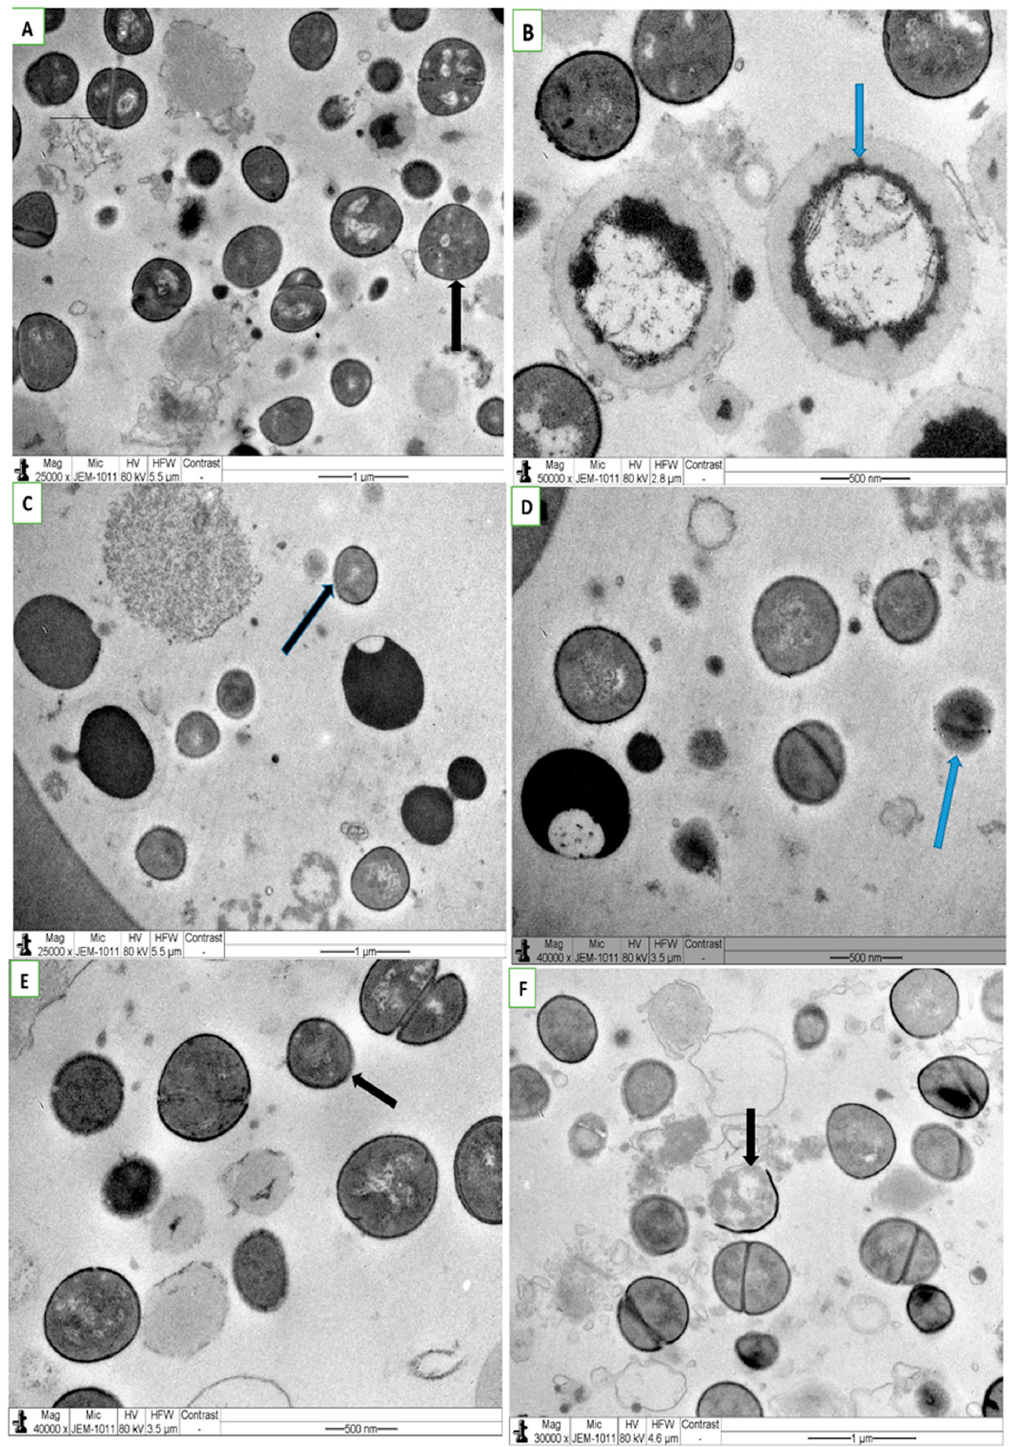
Figure 5. TEM micrographs of methicillin-resistant Staphylococcus aureus (MRSA) treated with NS and NS plus β -lactam antibiotics. ( A ) 5.0 µ g/mL of NS at 25,000 × showing MRSA 5 cell wall destruction (black arrow). ( B ) 5.0 µ g/mL NS plus oxacillin showing MRSA 4 cell death at 50,000 × magnification (blue arrow). ( C ) MRSA 5 treated with NS 5.0 µ g/mL plus augmentin at 25,000 × showing incomplete cell wall destruction (black arrow) and ( D ) MRSA 4 treated with 5.0 µ g/mL NS plus cefuroxime showing cell death (blue arrow) at 40,000 × magnifications. ( E ) MRSA 1 treated with 5.0 µ g/mL NS plus oxacillin and ( F ) MRSA 1 treated with 5.0 µ g/mL NS plus augmentin, showing cell wall destruction (black arrows) at a magnification of 30,000 ×